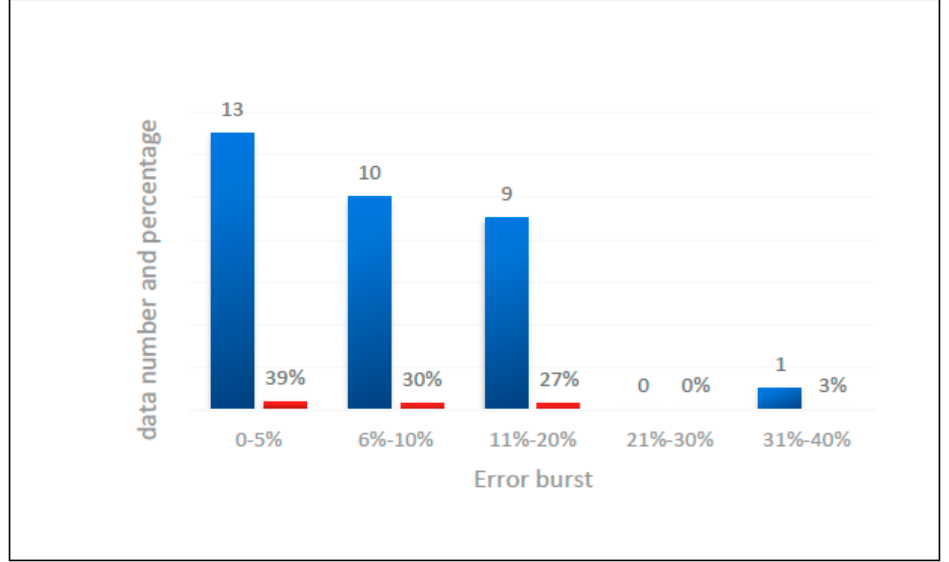
Figure 11. Calculation error distribution.